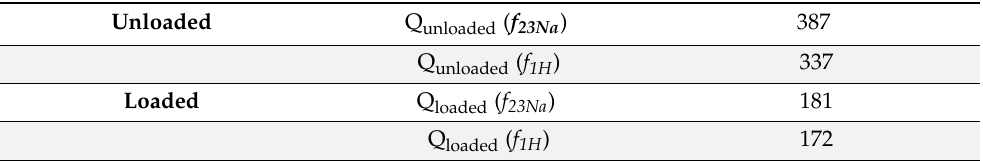
Table 4 . Q factors of the four-ring model measured at the sodium and proton Larmor frequencies at 7 T in the unloaded and loaded conditions.